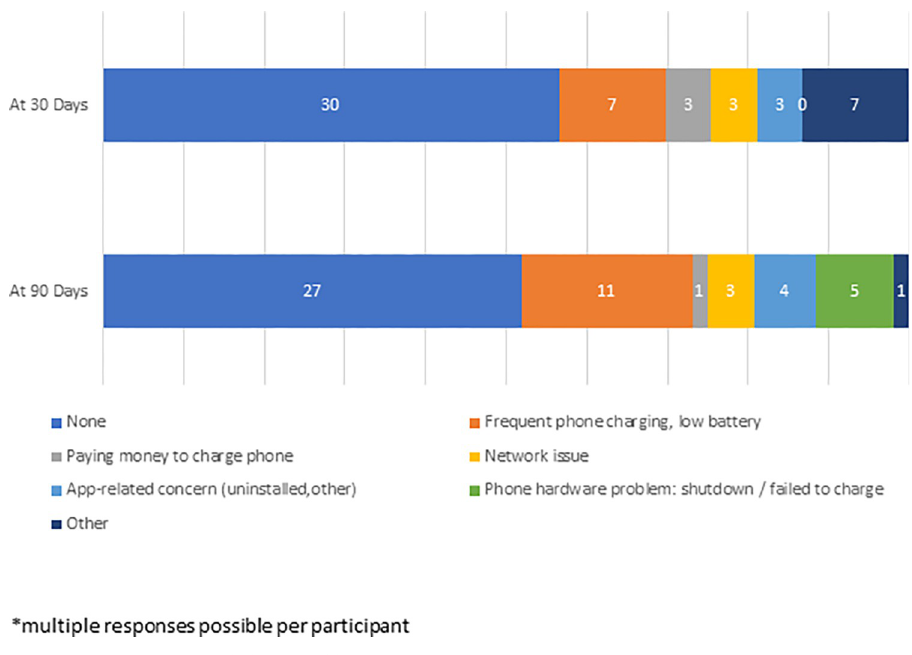
Fig 5. Participant-reported phone problems �